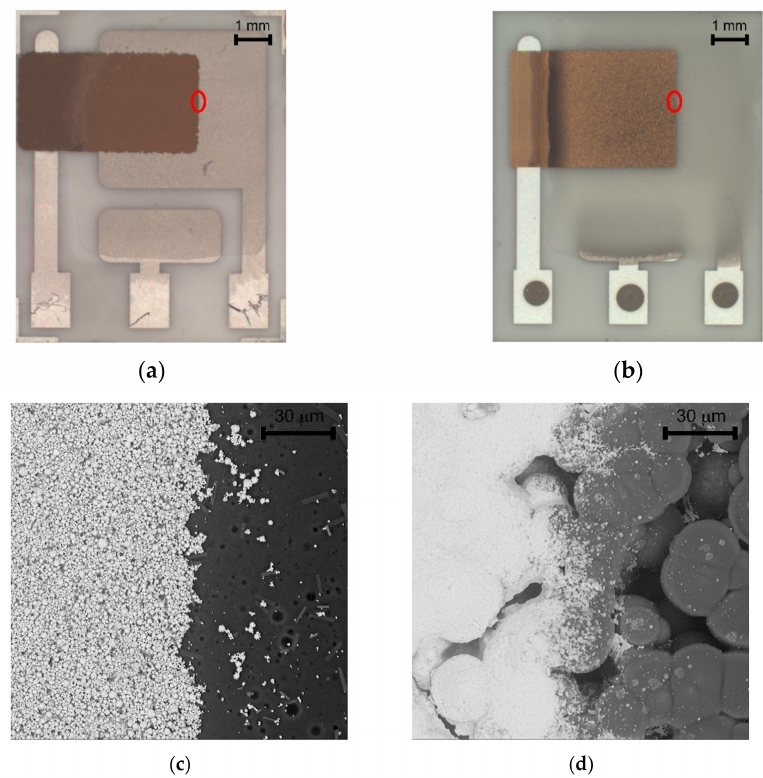
Figure 5. ( a ) Sensor with semi-planar topology and screen printed solid polymer electrolyte (SPE) layer and working electrode (WE) (SP-SCRP), ( b ) Sensor with semi-planar topology and drop-cast SPE layer and aerosol-jet printed WE (SP-AJP), ( c ) SEM image of the SPE/WE interface of the SP-SCRP sensor, ( d ) SEM image of the SPE/WE interface of the SP-AJP